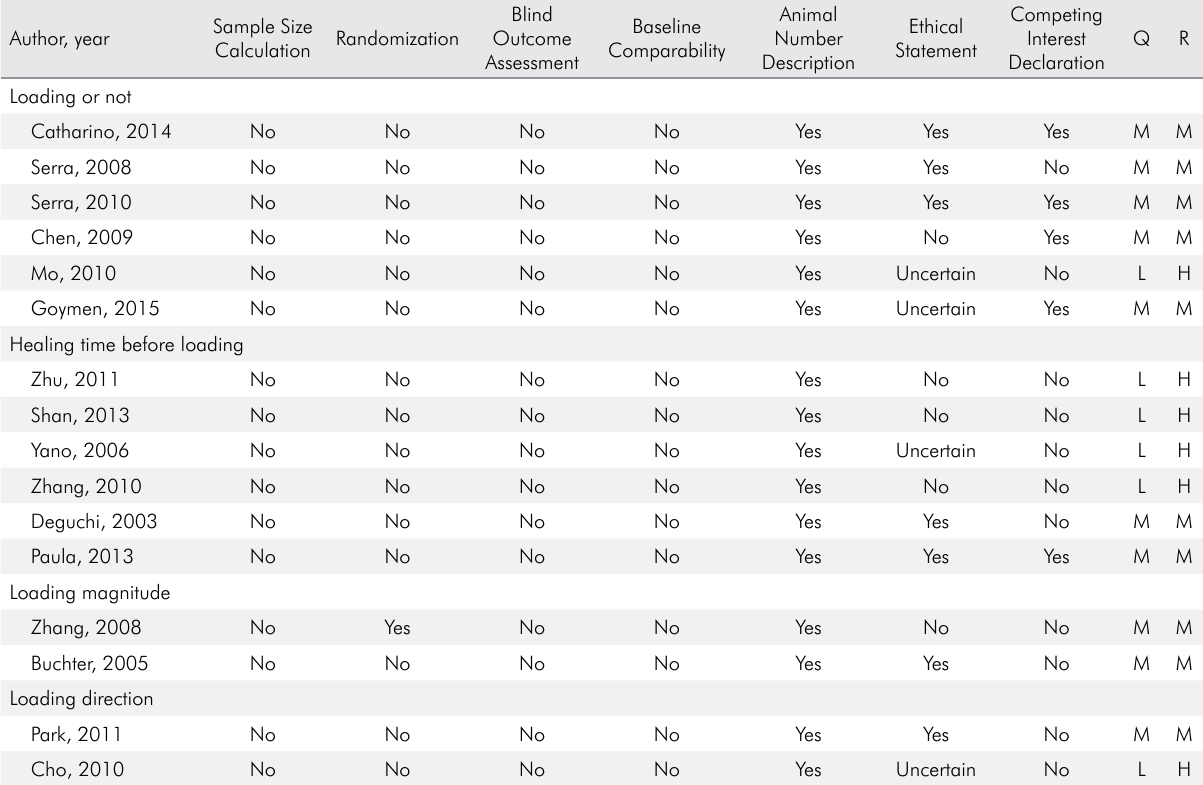
Table 1. Methodological quality and risk of bias of the selected studies with the Animal Research Reporting of In Vivo Experiments (ARRIVE)